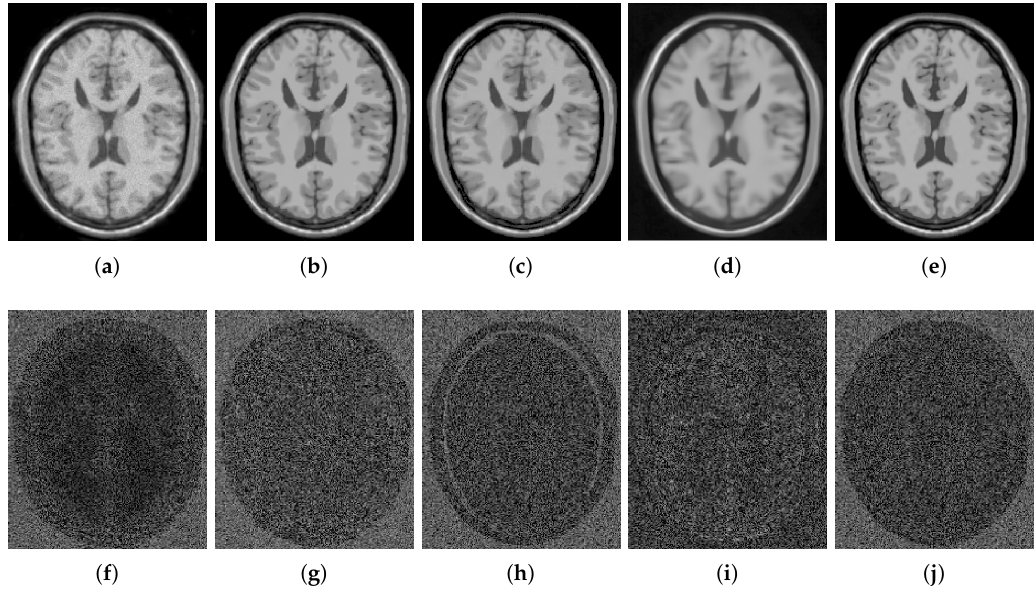
Figure 9. Residuals of the different results produced by the application of the methods evaluated on the noise-free T1w synthetic MR image of Figure 6a corrupted with 5% Rician noise. ( a – e ) are the denoising results of the methods KSVD, PRINLM, BM4D, DnCNN, and NLSD, respectively. ( f – j ) are the corresponding